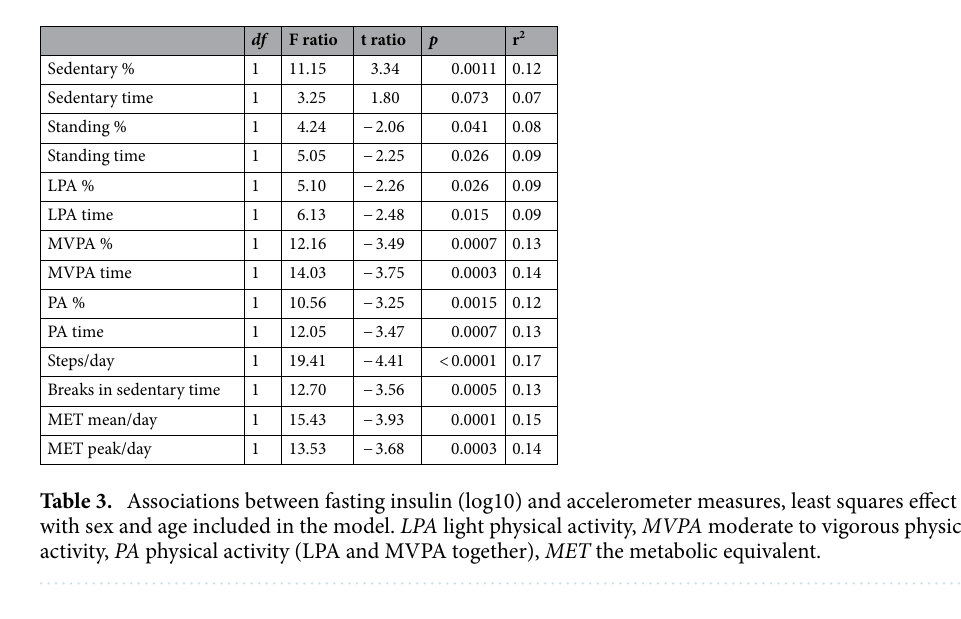
when adjusted for age, sex and usage of cholesterol lowering medication (Table 5). The associations of triglycer- ides with total PA and LPA were stronger than associations between triglycerides and MVPA. HDL-cholesterol associated negatively with SB time and SB percentage, when adjusted for age, sex and usage of cholesterol lowering medication (Table 6). Longer duration of LPA, MVPA and total PA were associated with higher HDL. There was no association between standing and HDL. See Supplementary Tables S9 and S10 for details of the full models. No associations were found between total or LDL-cholesterol and accelerometer measures when adjusted for age, sex and usage of cholesterol lowering medication (Supplementary Tables S11, S12). See Supplementary Table S13 for details of the full models. The unadjusted associations between plasma lipids and accelerometer measures are presented in Supplementary Fig. S2. Blood pressure and heart rate. No associations were found between accelerometer measures and blood pressure, even if adjusted for age, sex and usage of antihypertensive medication (data not shown). Lower resting heart rate associated significantly with more breaks in sedentary time (p = 0.018). All the above-mentioned associations are summarized in Table 7.